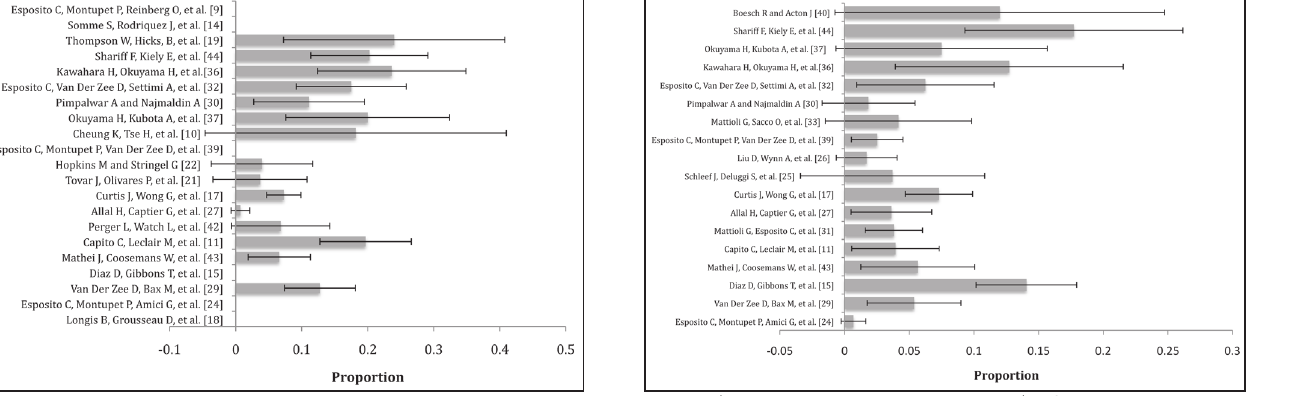
Figure 4) Reoperation rates. Bars represent 95% CIs Figure 2) Mortality rates. Bars represent 95%